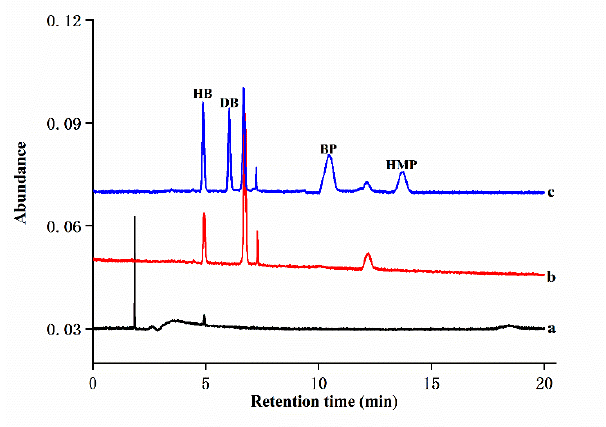
Figure 3. Chromatograms of the factory wastewater sample. Chromatograms of a, b, and c repre- sented wastewater samples before and after extraction and spiked standard samples after extrac- tion, respectively.